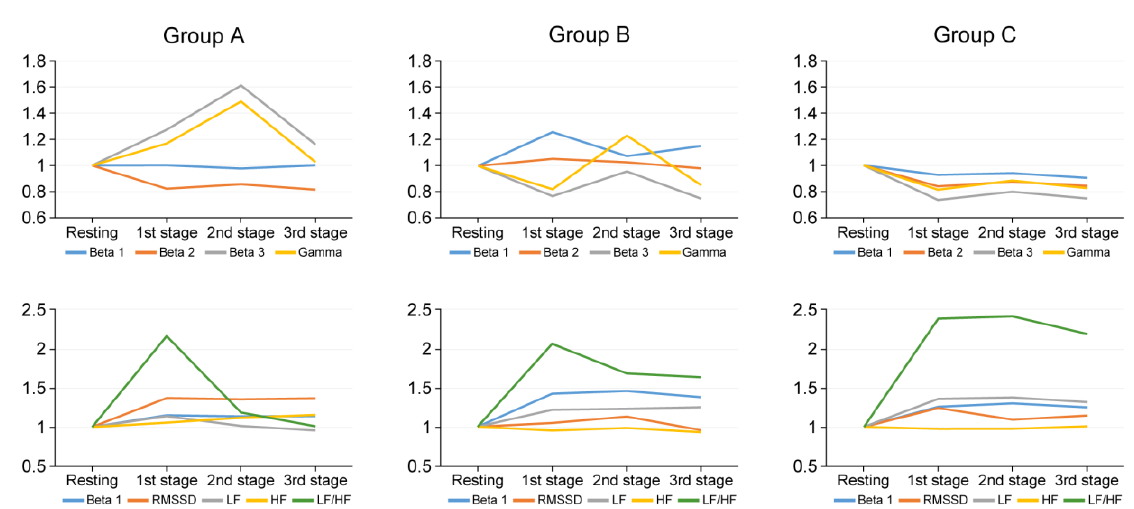
Figure 2. Pattern of stress related EEG waves and HRV parameters according to the experience of surgeon and three stages over time during surgical procedure. According to experience of surgeon; Group A, less than 5 years; Group B, from 5 years to less than 15 years; Group C, more than 15 years; Beta 1, low beta waves, 12–15 Hz; Beta 2, mid-range beta waves, 15–20 Hz; Beta 3, high beta waves, 20–30 Hz; Gamma, 30–50 Hz. BPM: beats per minute, RMSSD: square root of the mean R-R interval; LF: low frequency, HF: high frequency.